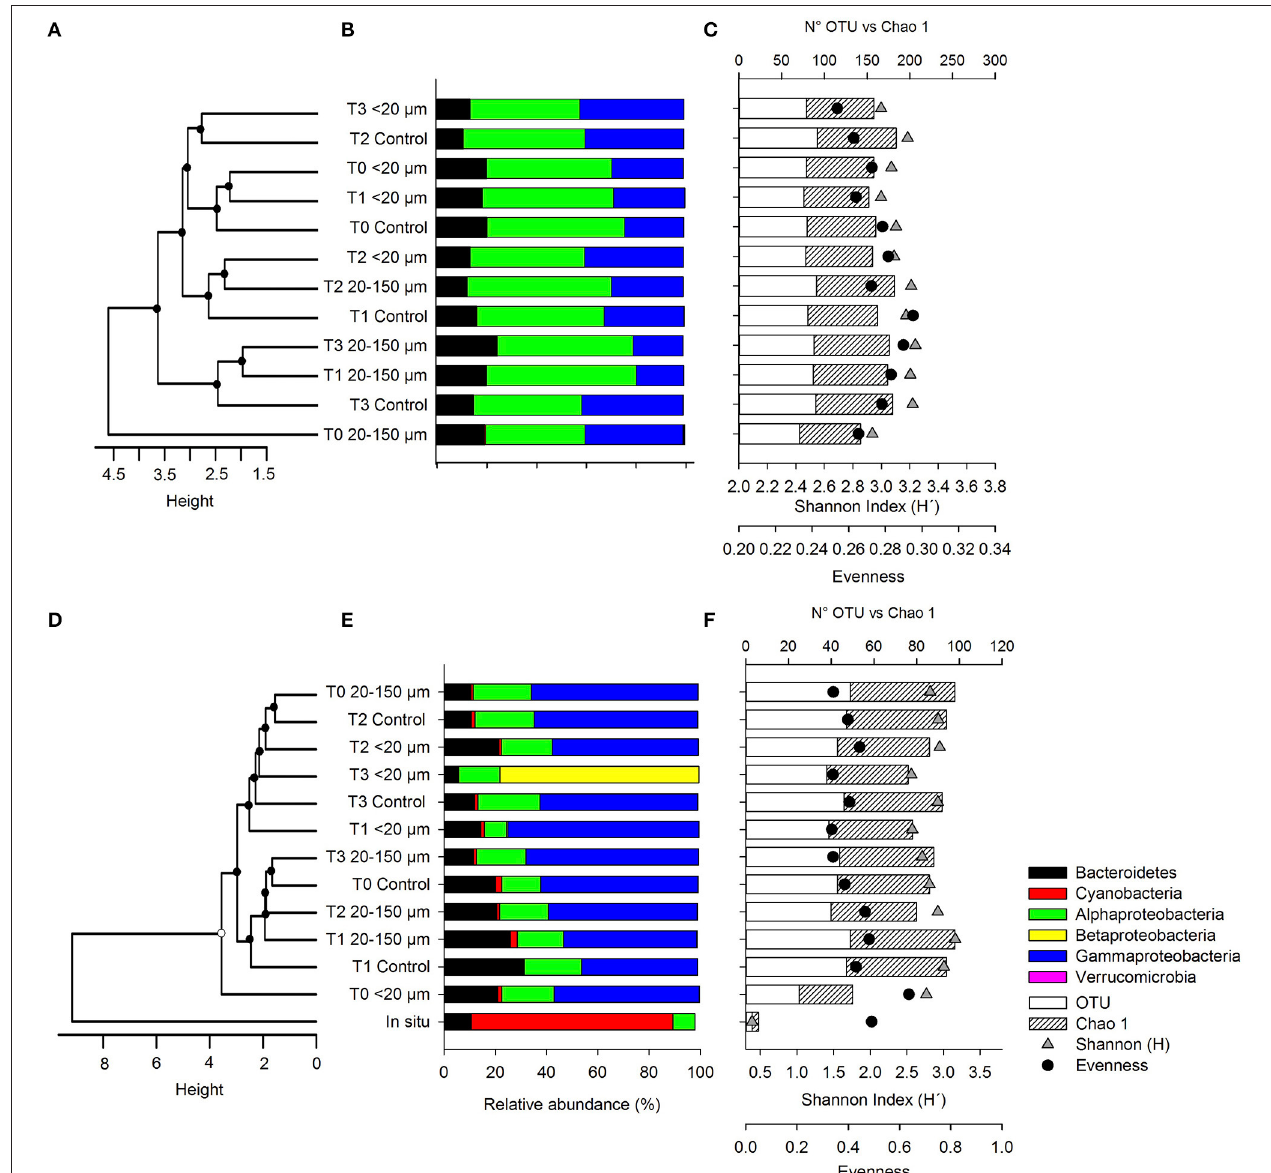
FIGURE 7 | (A–D) Unweighted Pair Group Method with Arithmetic mean (UPGMA) clustering of active bacteria community structure in late summer and spring. Bootstrap values obtained from 1,000 interactions are depicted as circles on nodes (black: > 80% and white: < 70%), (B–E) taxonomic composition of